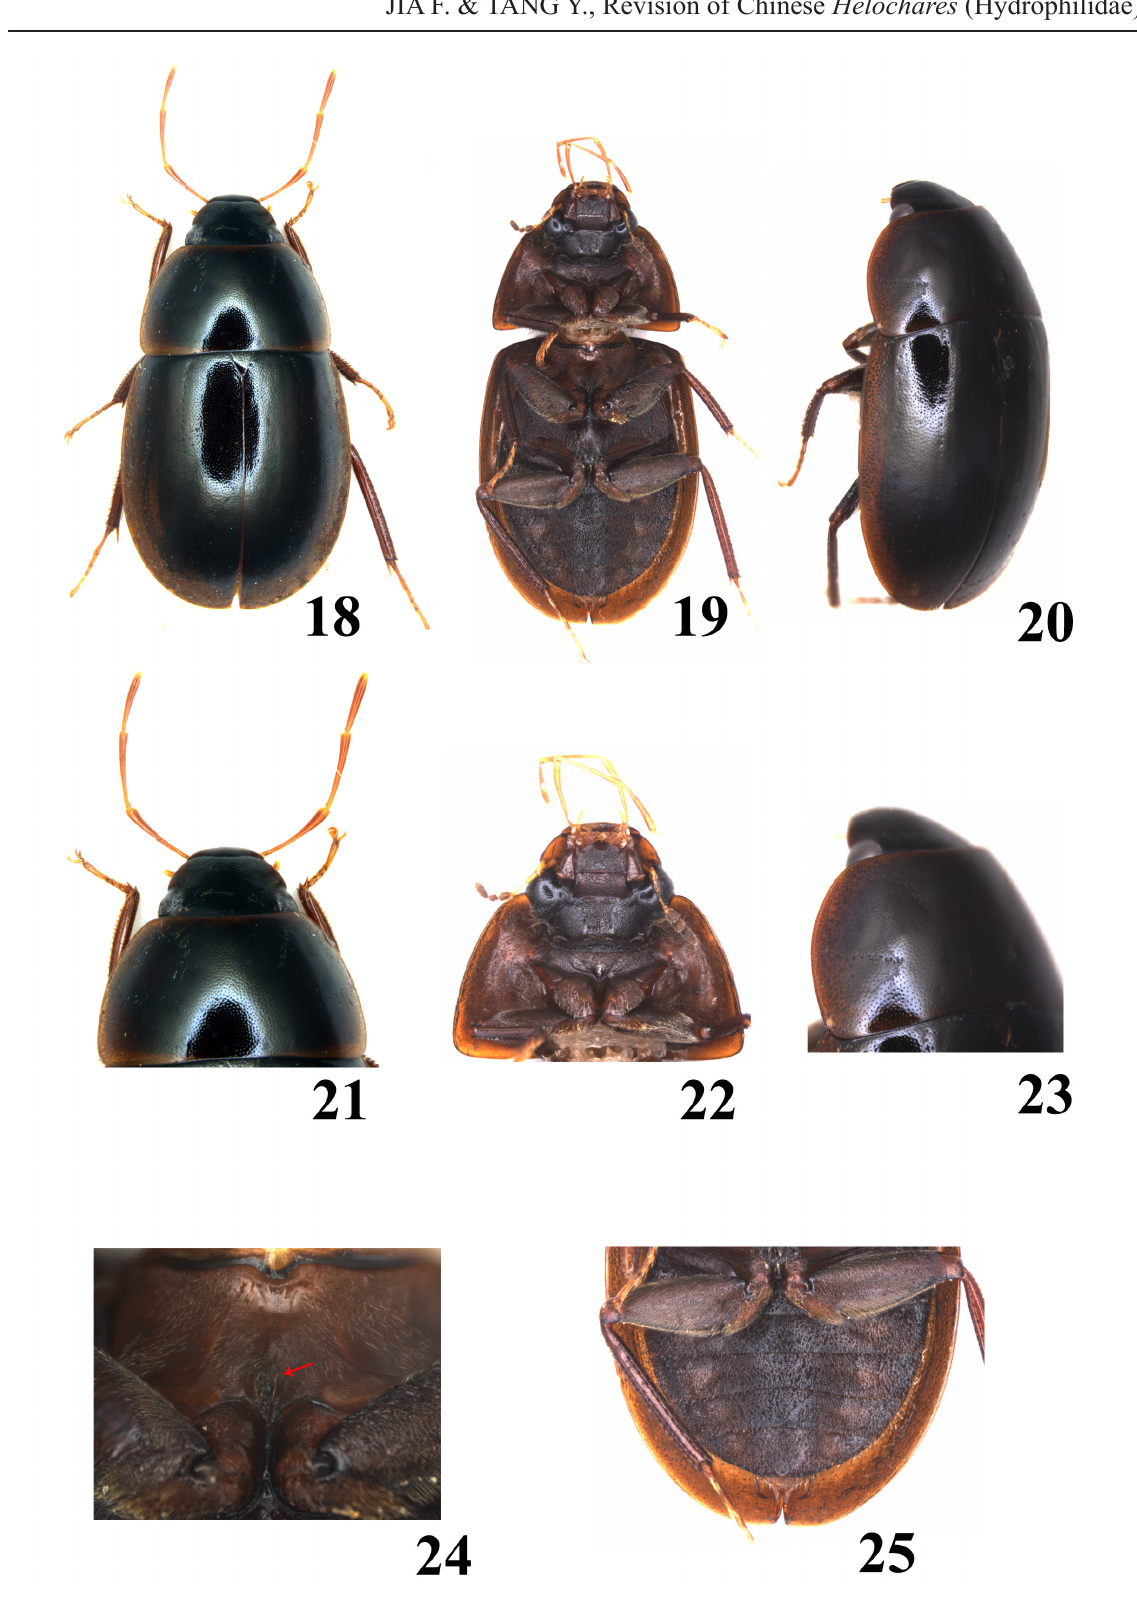
Figs 18–25. Helochares atropiceus Régimbart, 1903. 18–20 . Habitus. 18. Dorsal. 19. Ventral. 20.